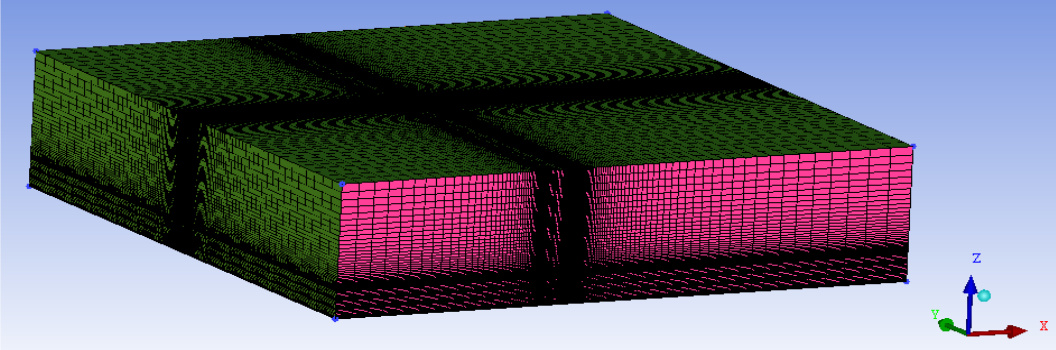
Fig. 4. Isometric view of the meshing of the